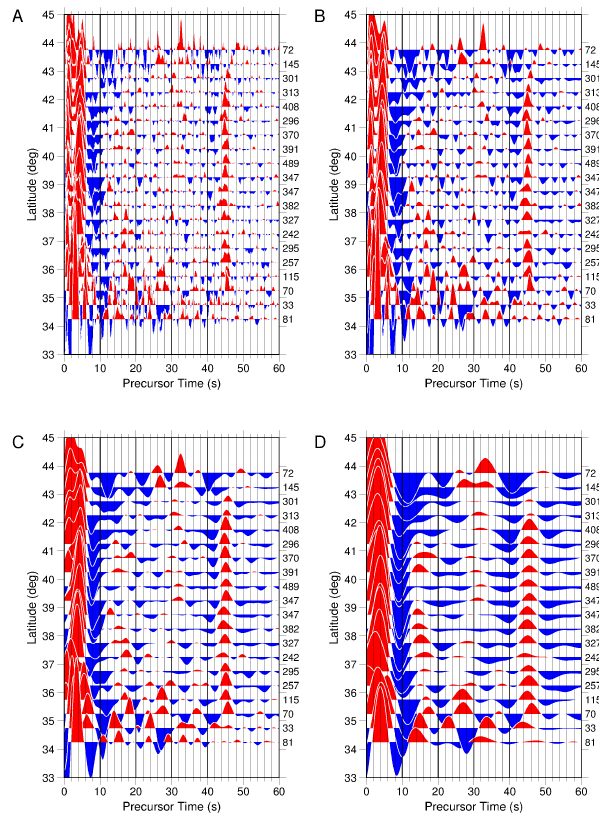
Figure 11. Same S-receiver functions as in Fig. 6b for different fil- ters: (a) no filter, (b) 2s low-pass filter, (c) 4s low-pass filter and (d) 8s low-pass filter. At shorter periods ( a and b ) the LAB (blue signal around 10s) may consist of several smaller discontinuities. Only for the 6 and 8s low-pass filters it appears as a single discon- tinuity. In contrast, the Moho and the discontinuity at 410km depth (red signals around 5 and 45s, respectively) remain as sharp single discontinuities at all periods, suggesting that this behavior is due to structure rather than to the higher noise levels at shorter